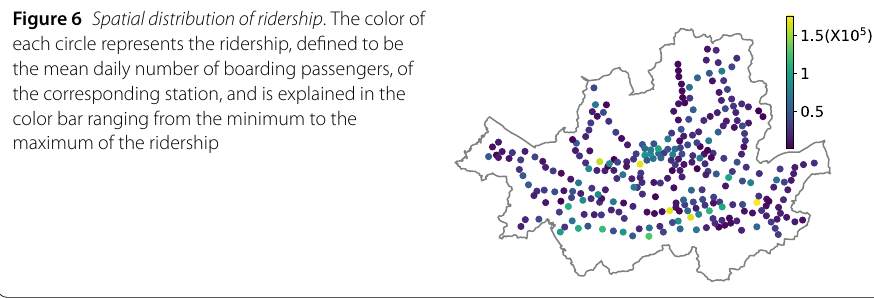
Figure 6 Spatialdistributionofridership . The color of each circle represents the ridership, defined to be the mean daily number of boarding passengers, of the corresponding station, and is explained in the color bar ranging from the minimum to the maximum of the